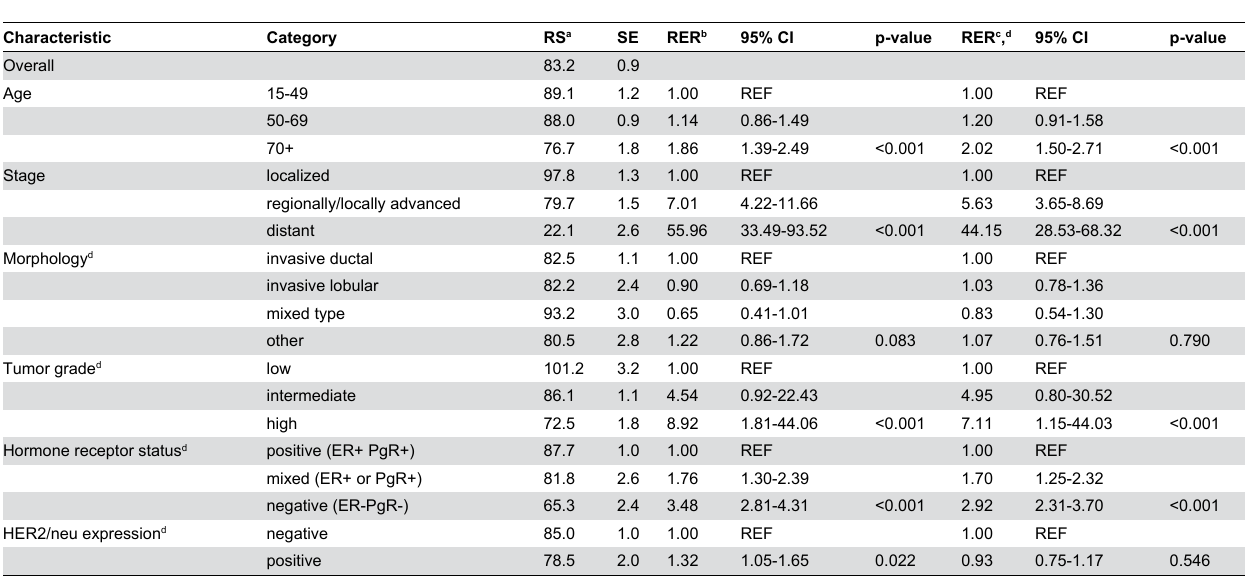
Table 2. Five-year relative survival and relative excess risk of death of female patients from Saarland with invasive breast cancer (ICD-10 code: C50) estimated for the calendar period 2005-2009 by age and tumor characteristics based on completed